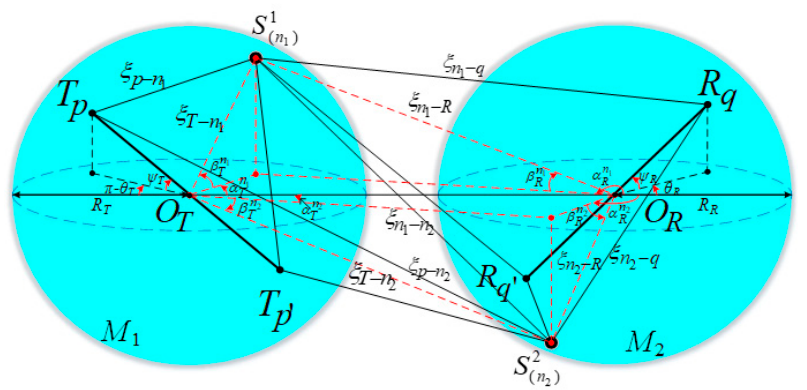
Figure 1. Proposed 3D double-spheres model capturing local scatterer distribution for mobile Internet of Things (IoT) scenarios.